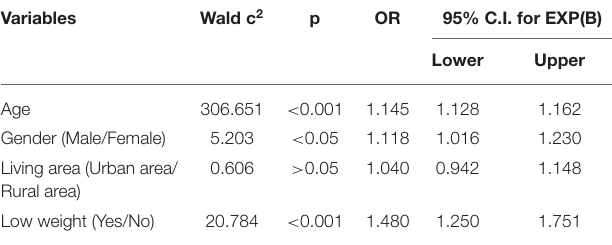
TABLE 4 | Logistic analysis of influencing factors for prevalence of scoliosis screening positive among